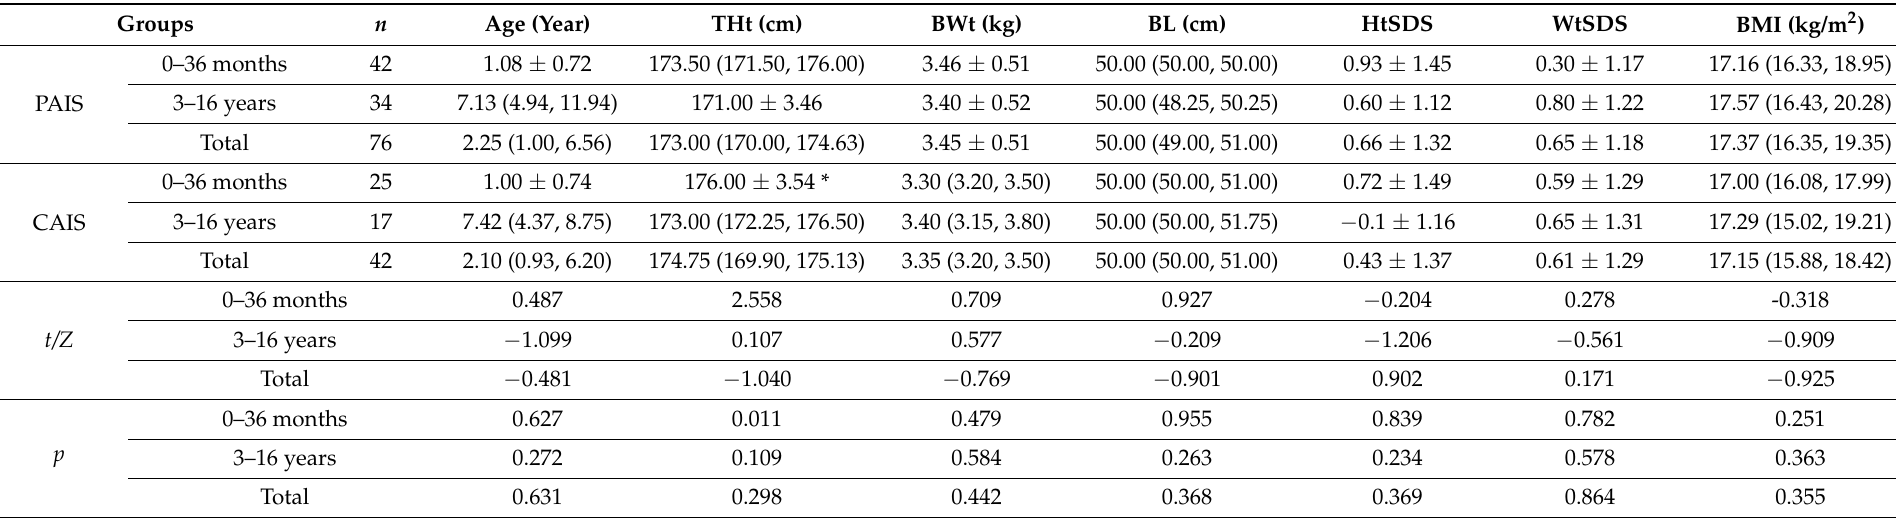
Table 2. Clinical parameters of Chinese children with PAIS and